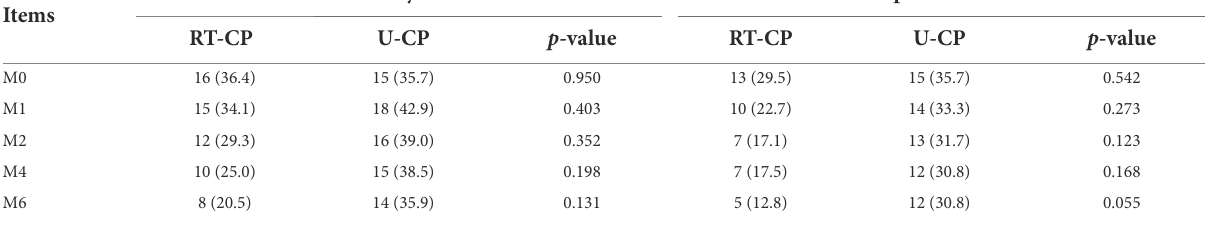
TABLE 2 Comparison of anxiety and depression rate among the older PTC patients.